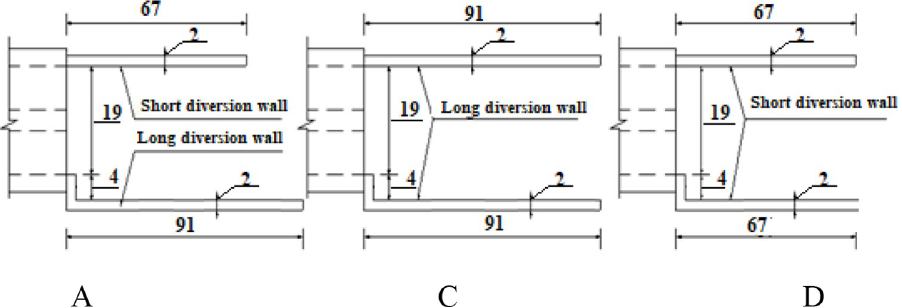
Fig 3. Dimension (in cm) of headwall